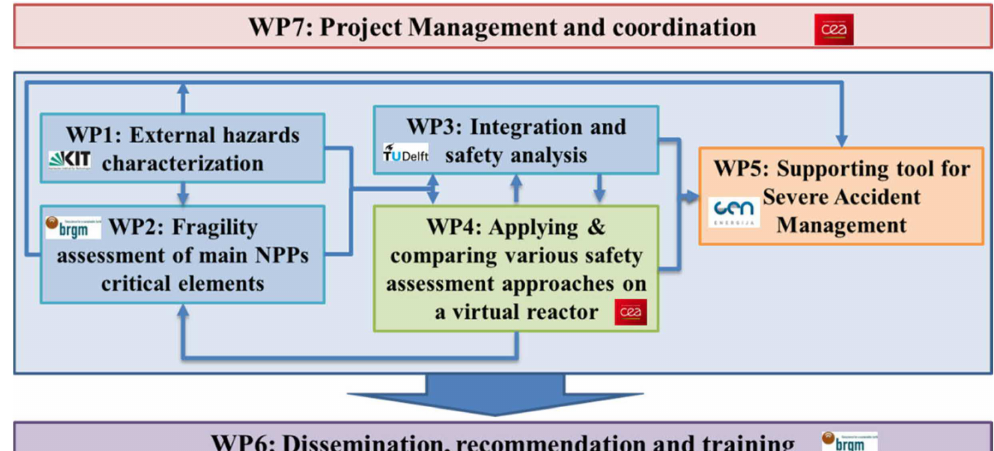
Fig. 2. NARSIS overall